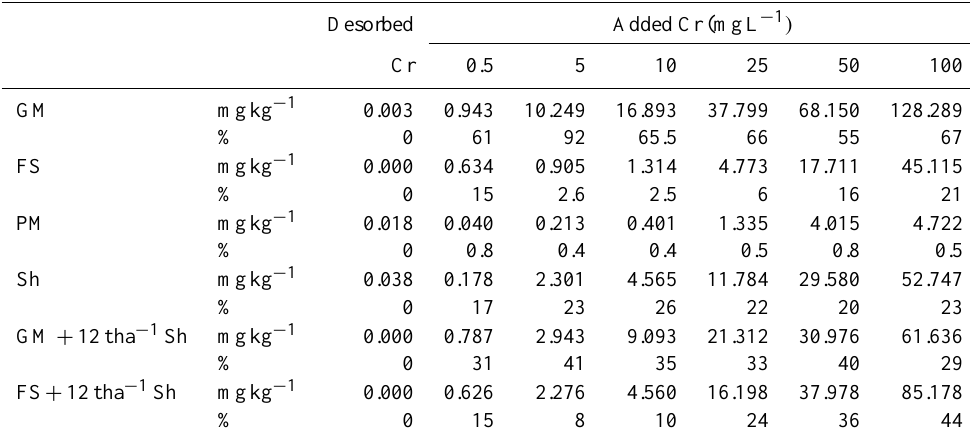
Table 4. Desorbed Cr (mgkg − 1 and % of the amount previously retained) when 0, 0.5, 5, 10, 25, 50, or 100mgL − 1 Cr was previously added to the various